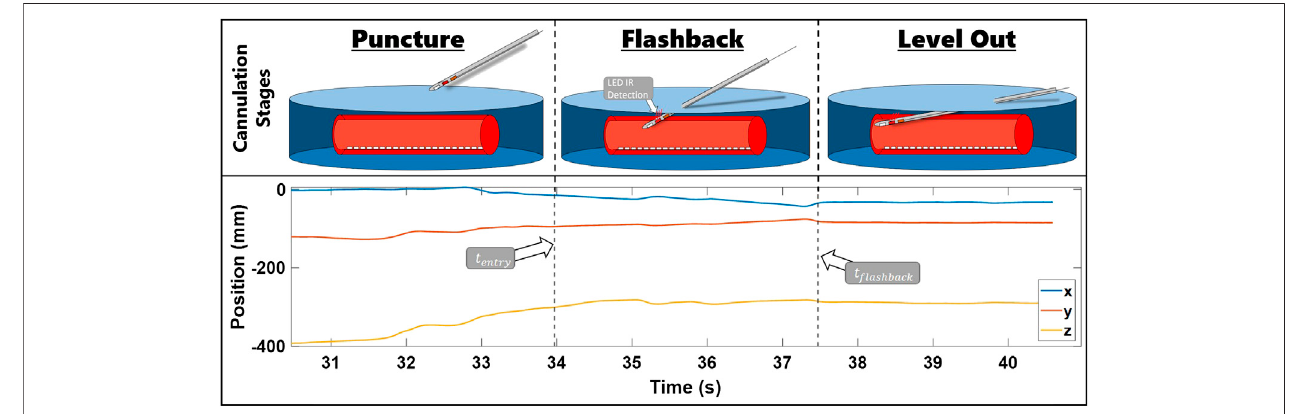
FIGURE3| Stepsofneedleinsertionillustrated alongsideanexampleoftrialpositiondata.Theimagesshowtheneedleapproachingthe fi stula,enteringthe fi stula and receiving fl ashback, and leveling out the needle. x , y , and z needle positions during these stages are presented in the bottom row plot. The position data are segmented by t entry (the fi rst dotted line) and t flashback (the second dotted line).